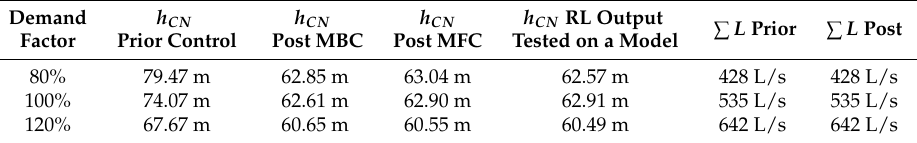
Table 2. Pressure observed on the critical node at 80%, 100% and 120% demand. h